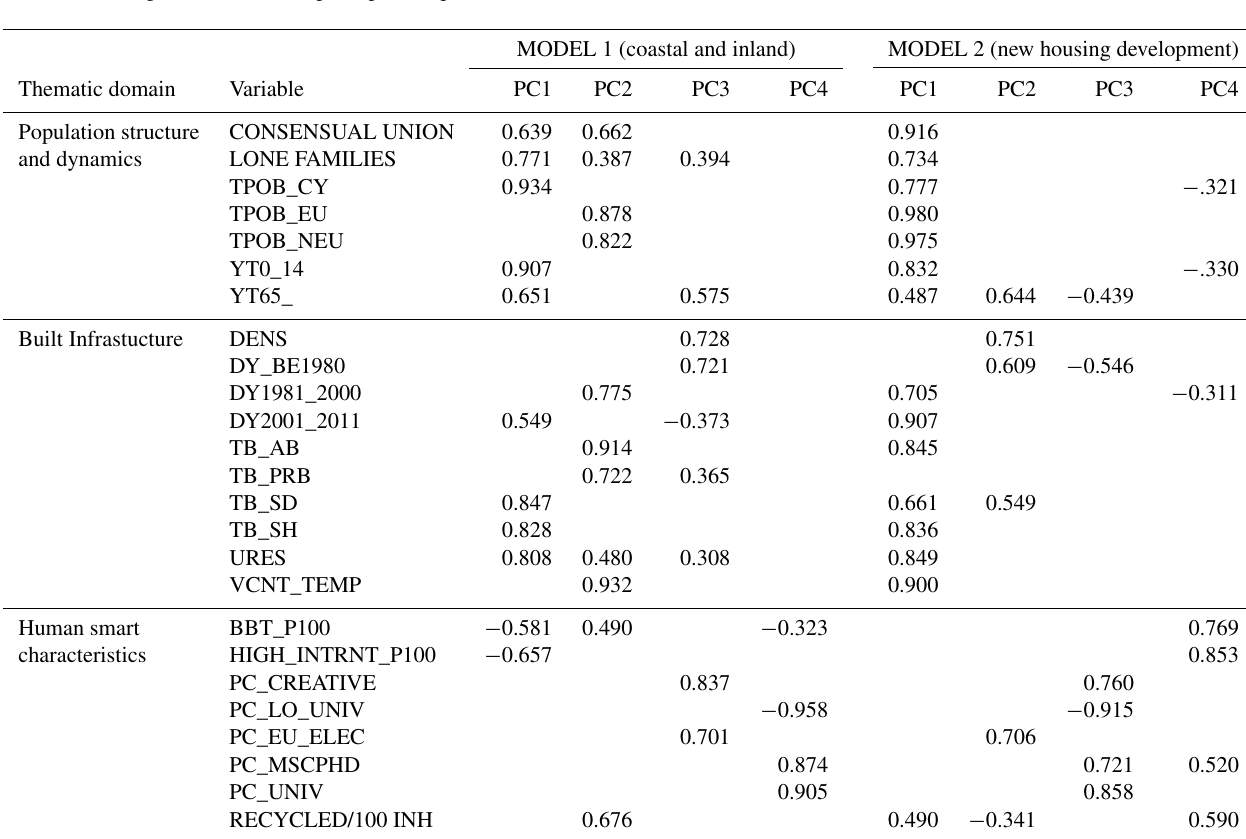
Table 6. Loadings ( > | 0 . 3 | ) on the principal